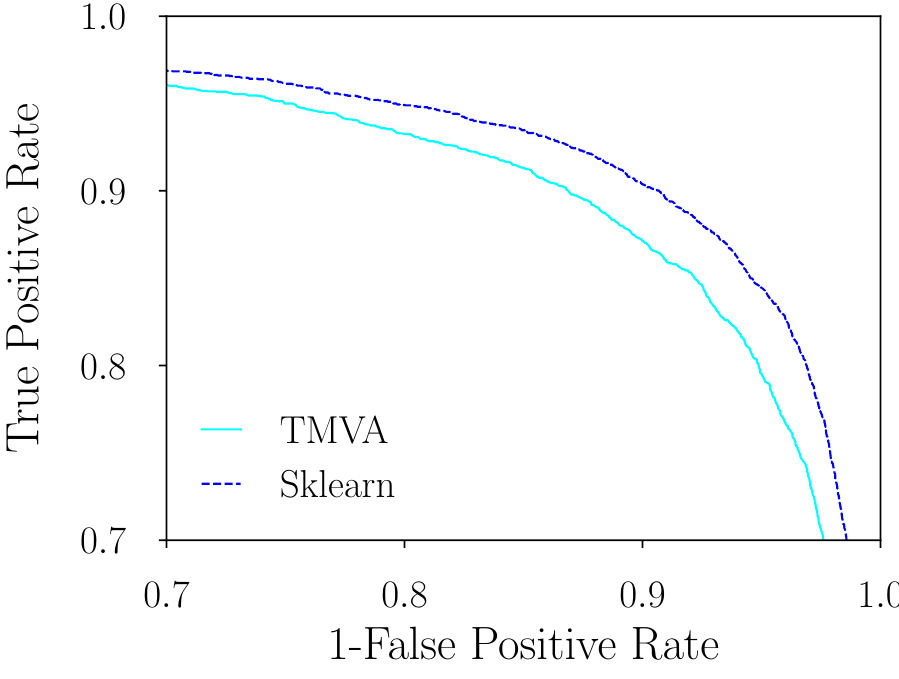
Figure 5. ROC Curve for the B µ + µ − decay, corresponding to the high-level features and high → stats option for training. Table 4. TMVA vs. Sklearn results: AUC scores for all four decay channels, corresponding to the high- level features and high stats option for training. The z value corresponds to a score [50,51] comparing the AUCs of pairs of classifiers under the hypothesis that they are the same. The corresponding p -values are all ∼